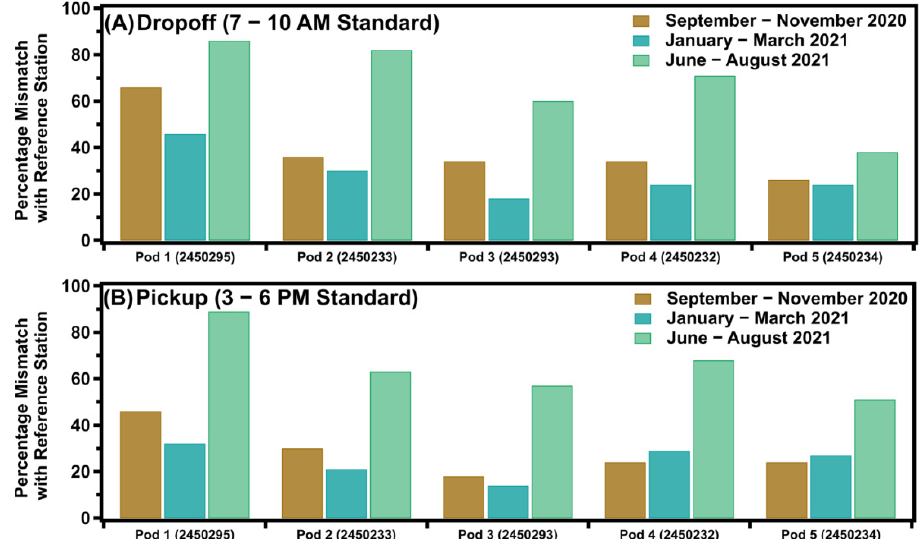
Figure 4. Percentage mismatch values calculated for all pods in the low-cost network for each time period. ( A ) Dropoff time interval comparisons across all network pods, ( B ) Pickup time intervals across all pod networks.